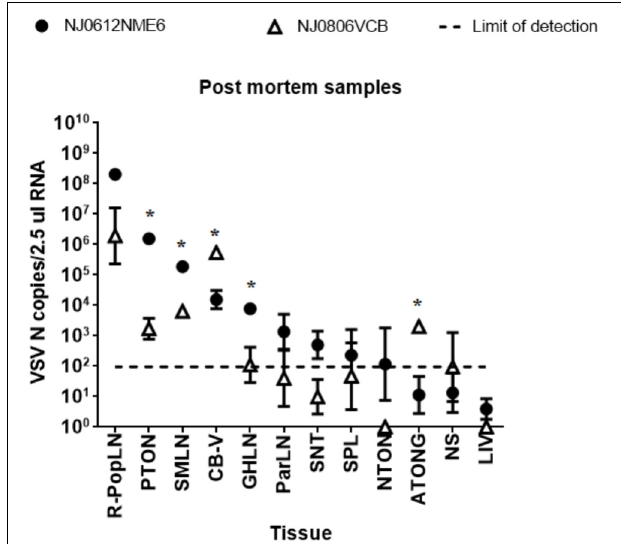
FIGURE 14 | Detection of viral RNA in postmortem samples. RNA from tissues collected at 21 dpi was analyzed by rRT-PCR to detect VSV nucleocapsid RNA. The dashed line represents the limit of detection of rRT-PCR (1.98 VSV n copies/2.5 µ l RNA). Values represent means and standard deviations for four pigs (two inoculated and two contact) from each group. Significant differences ( p < 0.05) between groups are indicated by asterisks ( ∗